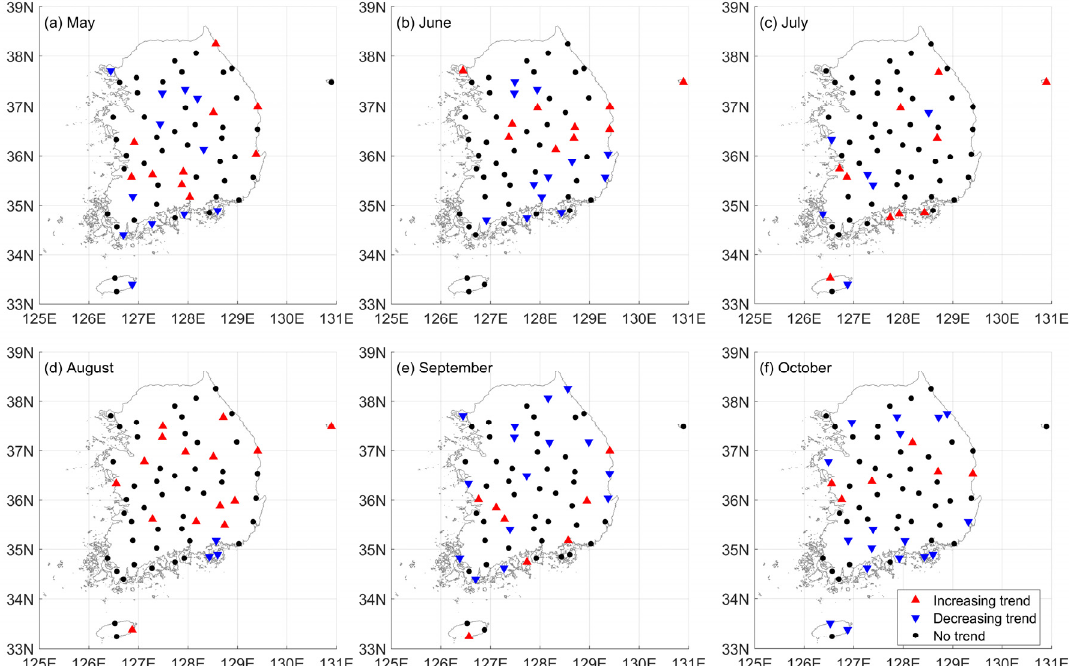
Figure 8. The trend test results of scaling exponent estimate series for the subsample sets of the AM series on the monthly basis in the rainy season (May to October): ( a ) May, ( b ) June, ( c ) July, ( d ) August, ( e ) September, ( f ) October. Note that subsample sets are extracted by the 20-year moving window from the whole AM series of each month and the significant levels of the employed trend tests are 5%.